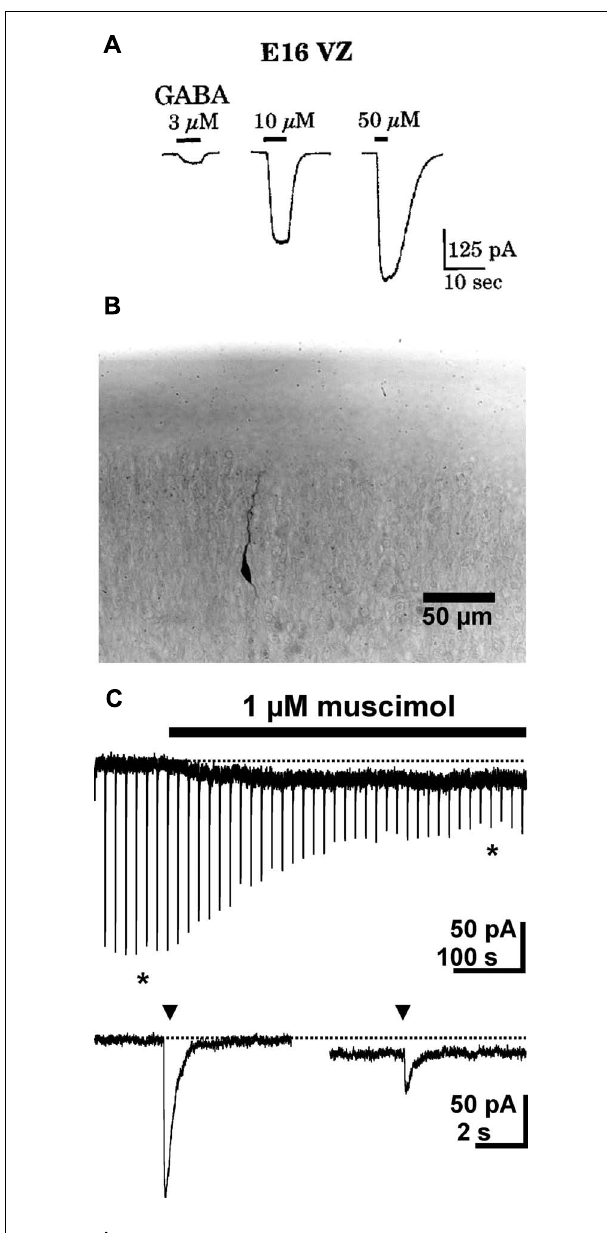
FIGURE 1 | GABAergic currents during early development. (A) Whole-cell recordings from cells in ventricular zone of embryonic rats (E16) revealed dose-dependent GABAergic currents. (B) Photomicrograph of a biocytin-stained migrating neuron in a P1 rat. (C) Whole-cell recordings show that in migrating neurons a short (2–3 ms) application of 1 mM GABA (triangles) induced fast inward currents, while bath application of 1 μ M muscimol induced a long lasting tonic current and led to a marked desensitization of phasic responses.The typical responses shown below the continuous trace are marked by asterisks. Pictures taken with kind permission from Owens etal. (1999) (A) and Heck etal. (2007) (B,C)